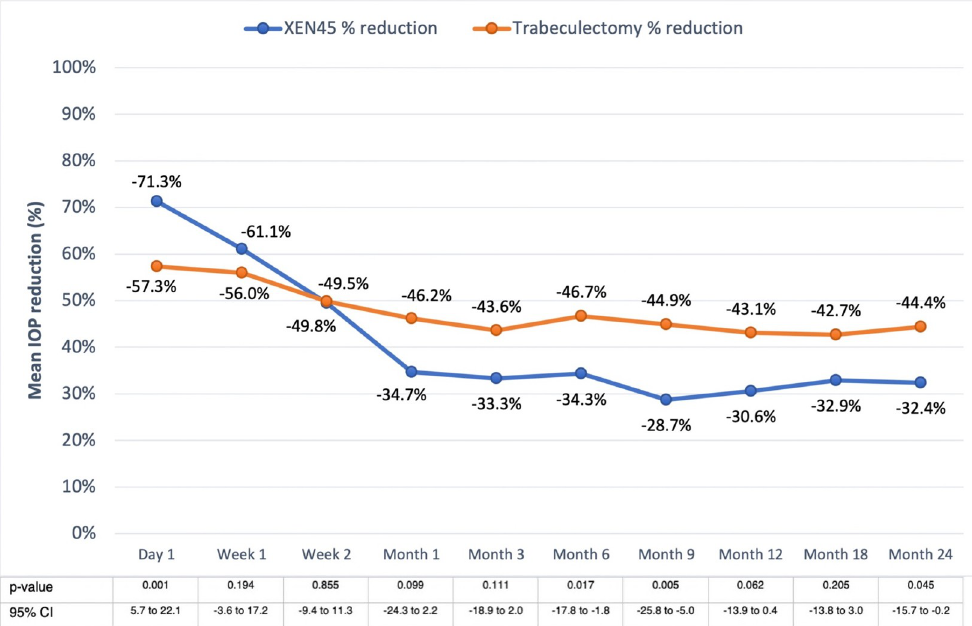
Fig 2. Mean intraocular pressure percent reduction of the XEN implant and trabeculectomy groups. Postoperative IOPs were significantly different on day 1, month 6, month 9 and month 24. Final mean IOP reduction was 32.4% in the XEN and 44.4% in the trabeculectomy